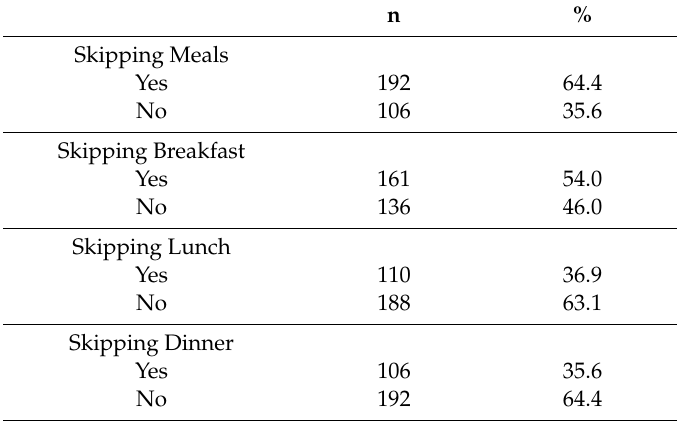
Table 2. Student distribution by meal type skipped: breakfast, lunch, dinner.